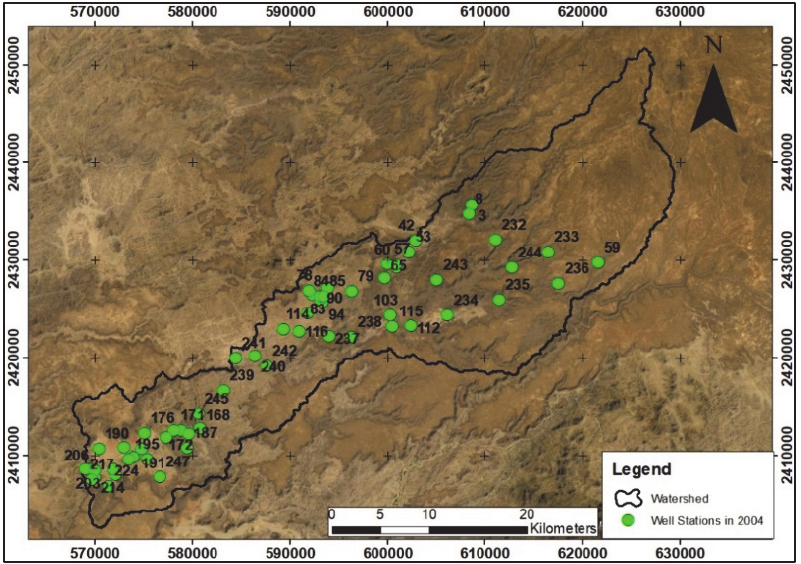
Figure 5. Well location based on El-Hames (2005) study. The data contain water table elevation and bottom of shallow aquifer information.